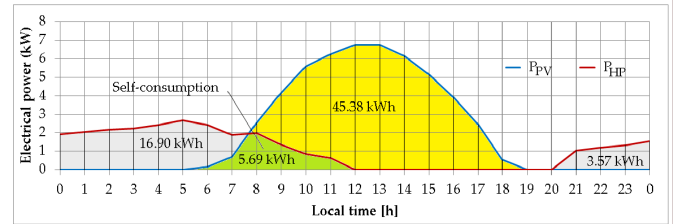
Figure 15. Simulated hourly the electrical power consumption of the geothermal heat pump (P HP ) and of the electrical power production (P PV ) of the photovoltaic platform (27 April 2020).